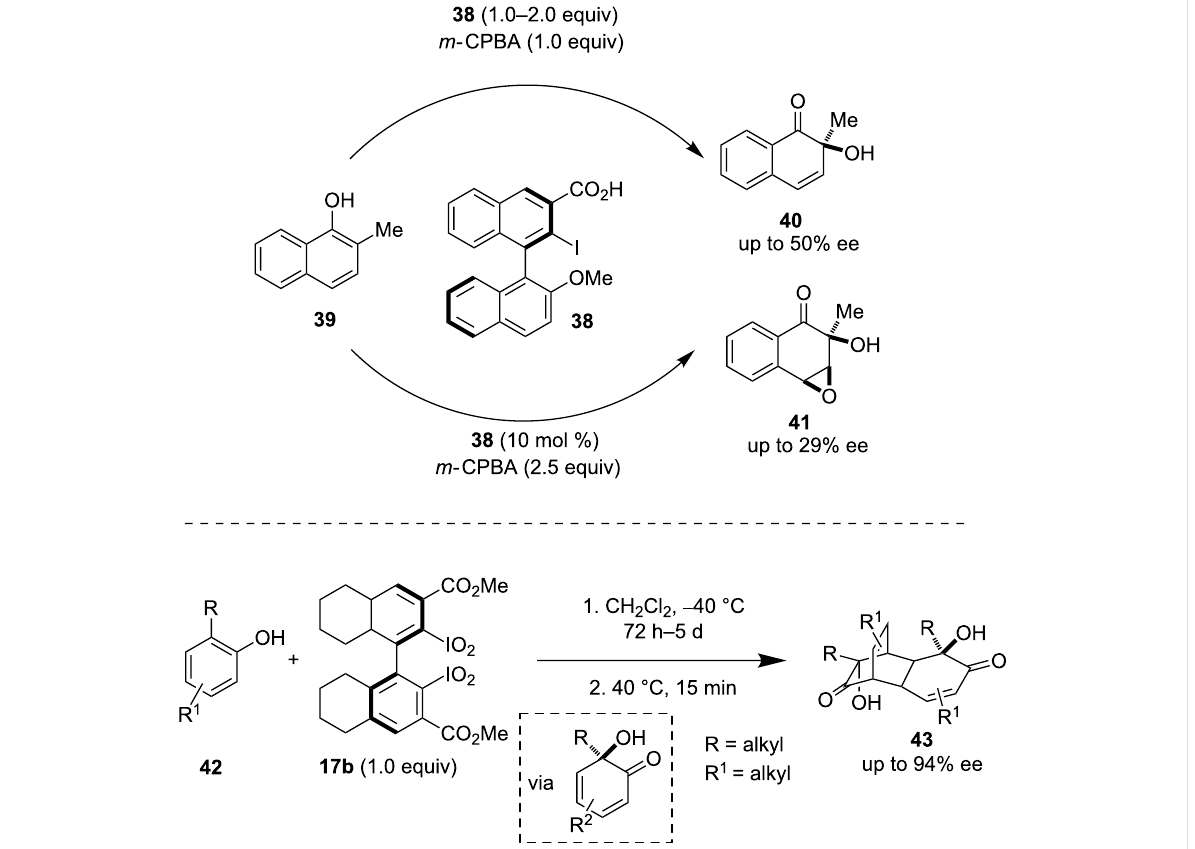
Scheme 8: Asymmetric hydroxylative